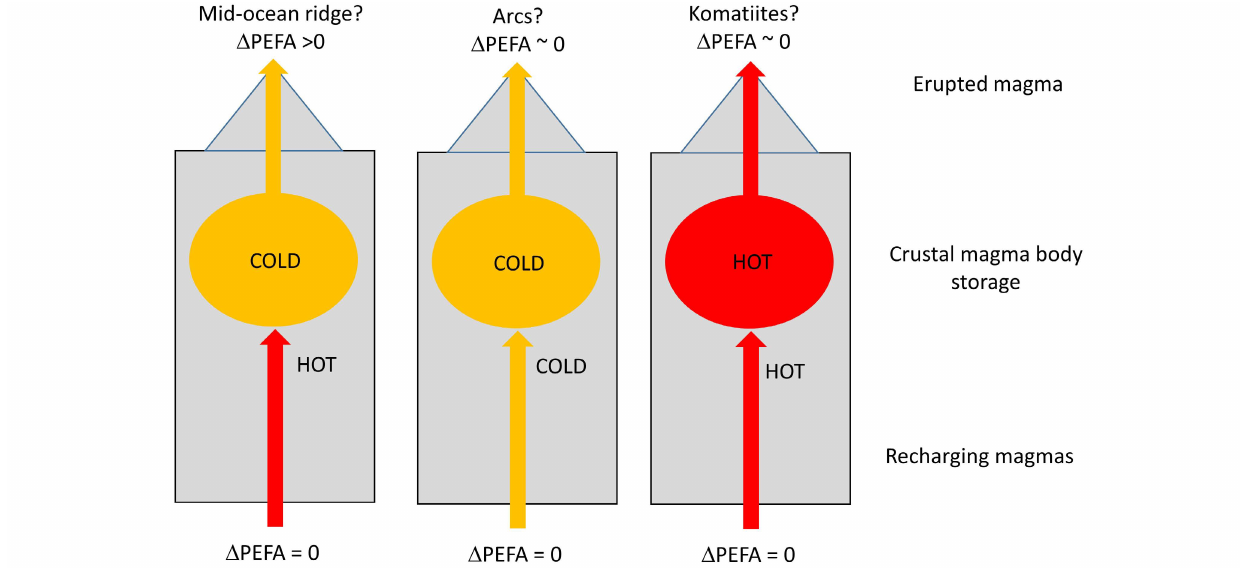
Figure 8: Scenario 1 for explaining differences in disequilibria. Disequilibria reflects temperature contrast between recharging magmas and crustal magma bodies where magmas reside and are stored. Large temperature contrasts between recharging magma and storage zones result in rapid cooling of the recharged magma, causing large disequilibrium ( Δ PEFA >0). In mid- ocean ridge environments, recharging magmas may be more primitive and hotter than the crustal magma body. In arcs, both the crustal magma body and recharging magmas might be evolved and cold, resulting in low temperature contrast and slower cooling rates. In komatiites, magma bodies and recharging magmas are both hot, resulting in low temperature contrast and slower cooling